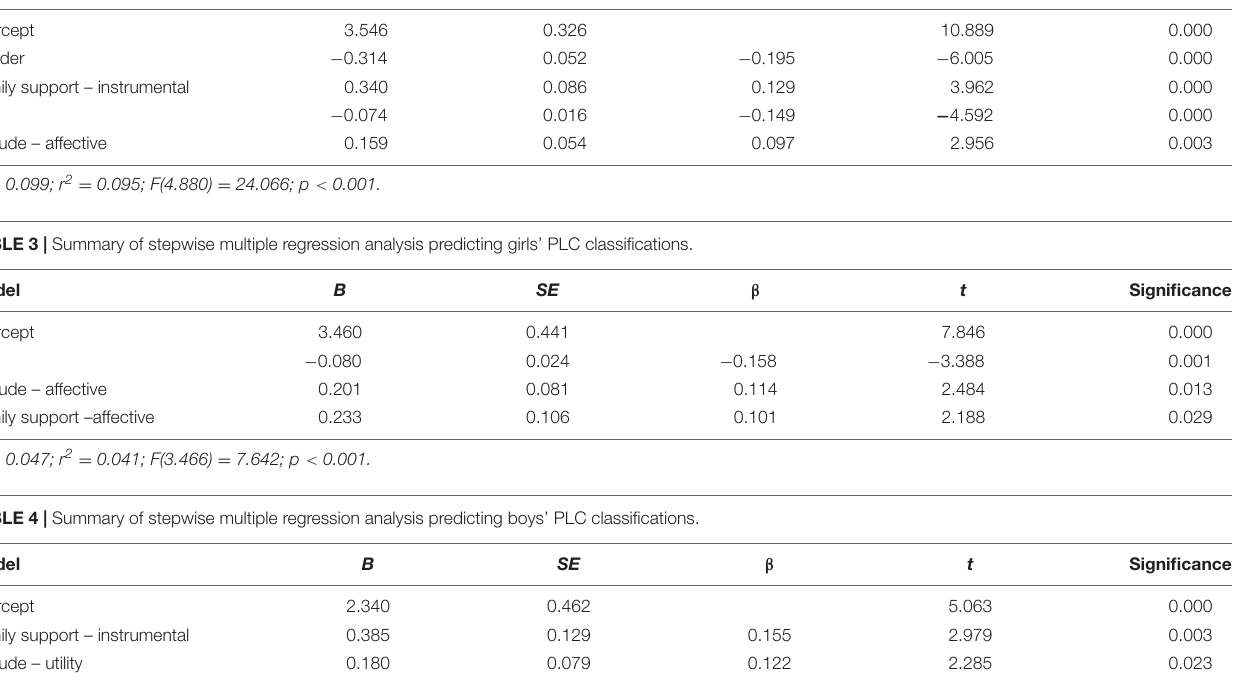
TABLE 2 | Summary of stepwise multiple regression analysis predicting academic classification in PLC. Model B